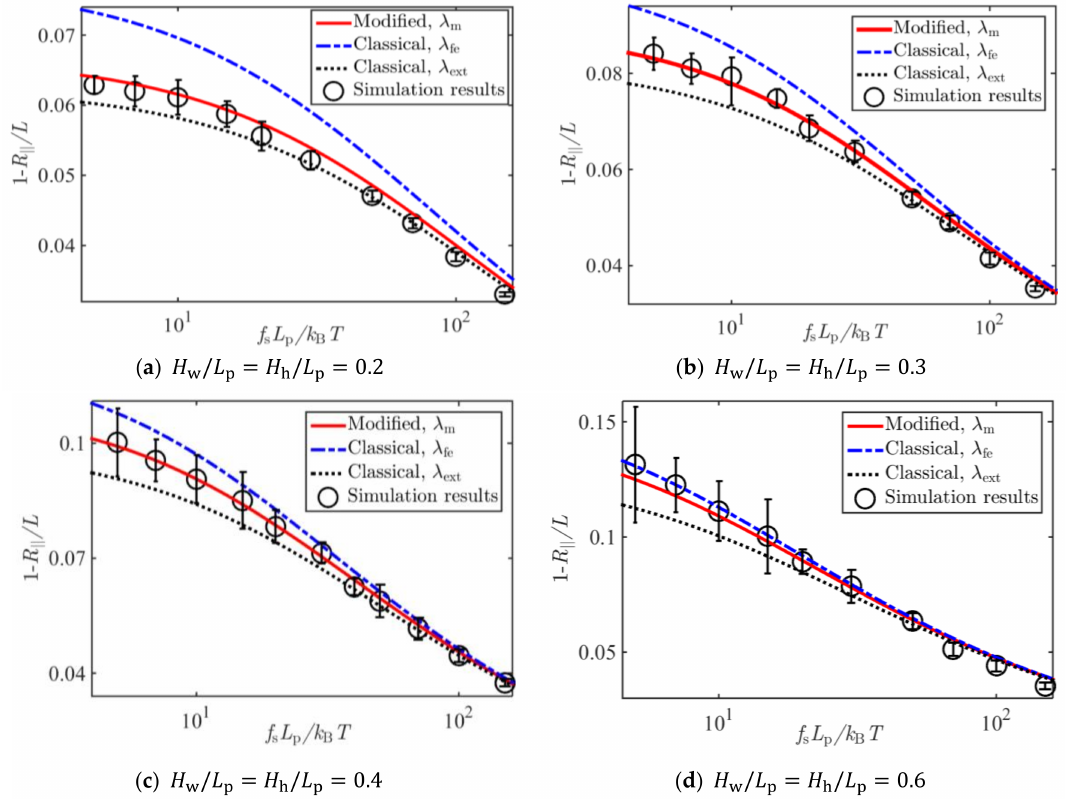
Polymers 2019 , 11 , 260 10 of 15